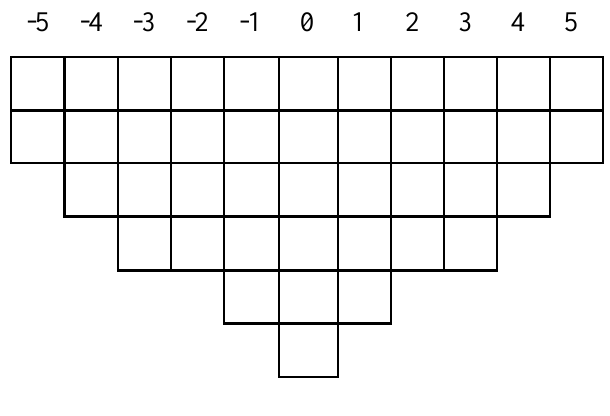
Table 2: Free-sort condition of instruction -5